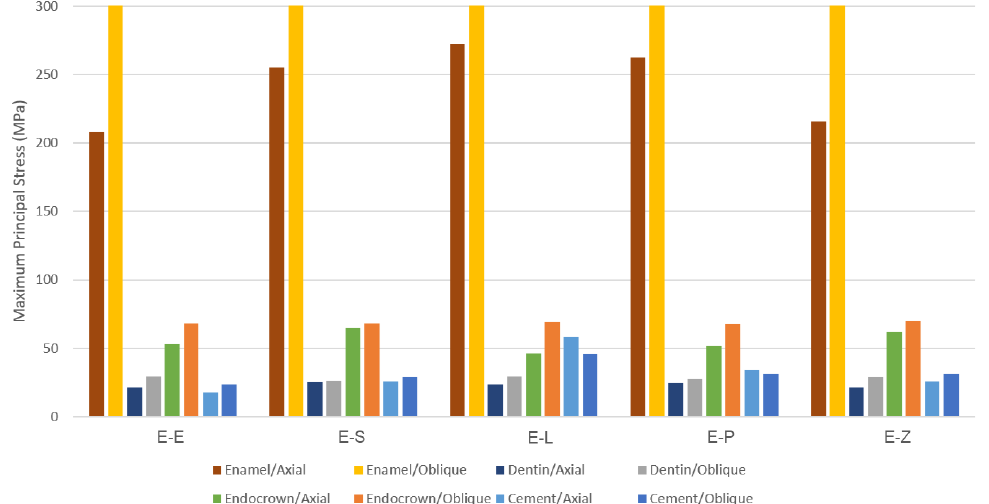
Figure 6. The maximum values of maximum principal stresses (MPa). E-E: lithium disilicate glass ceramic model, E-S: zirconia-reinforced lithium silicate ceramic model, E-L: resin nanoceramic model, E-P: polymer-infiltrated ceramic network model and E-Z: translucent zirconia model.